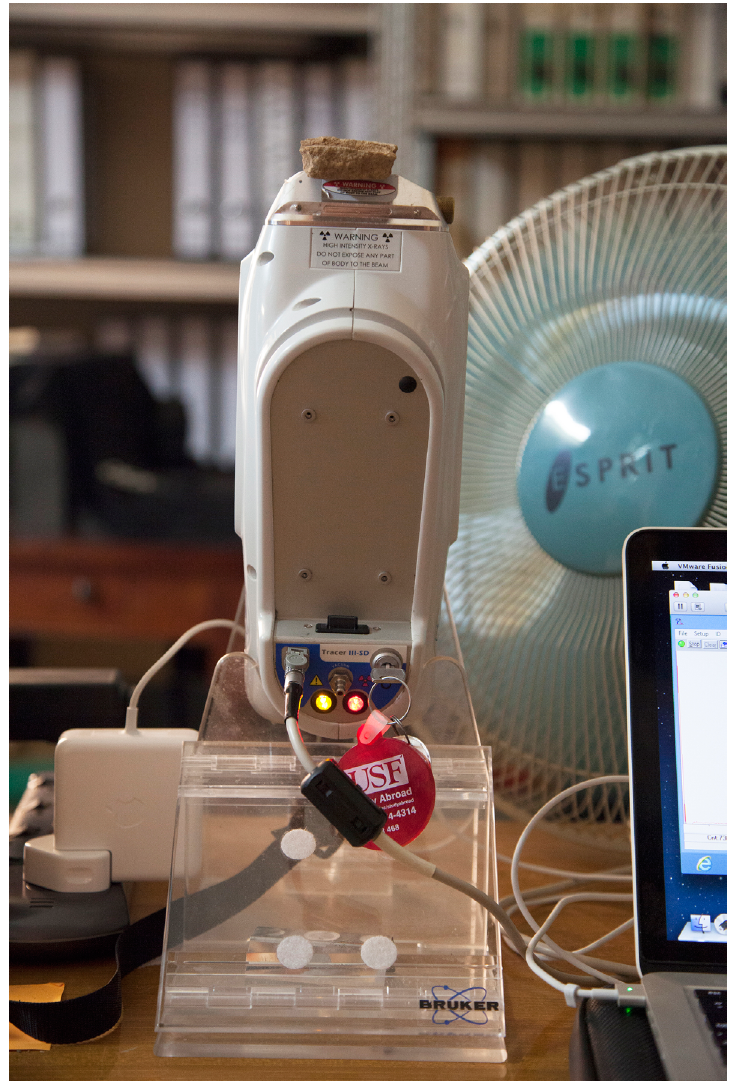
Figure 3. The Bruker Tracer III-SD portable X-ray fluorescence spectrometer (pXRF) analyzing a ceramic sherd at the National Museum of Archaeology, Valletta, Malta (photograph by Fred